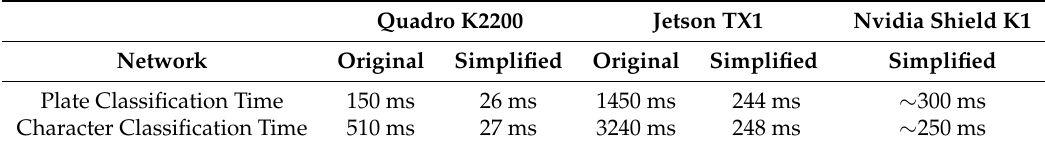
Table 1. Execution times of original and simplified networks.